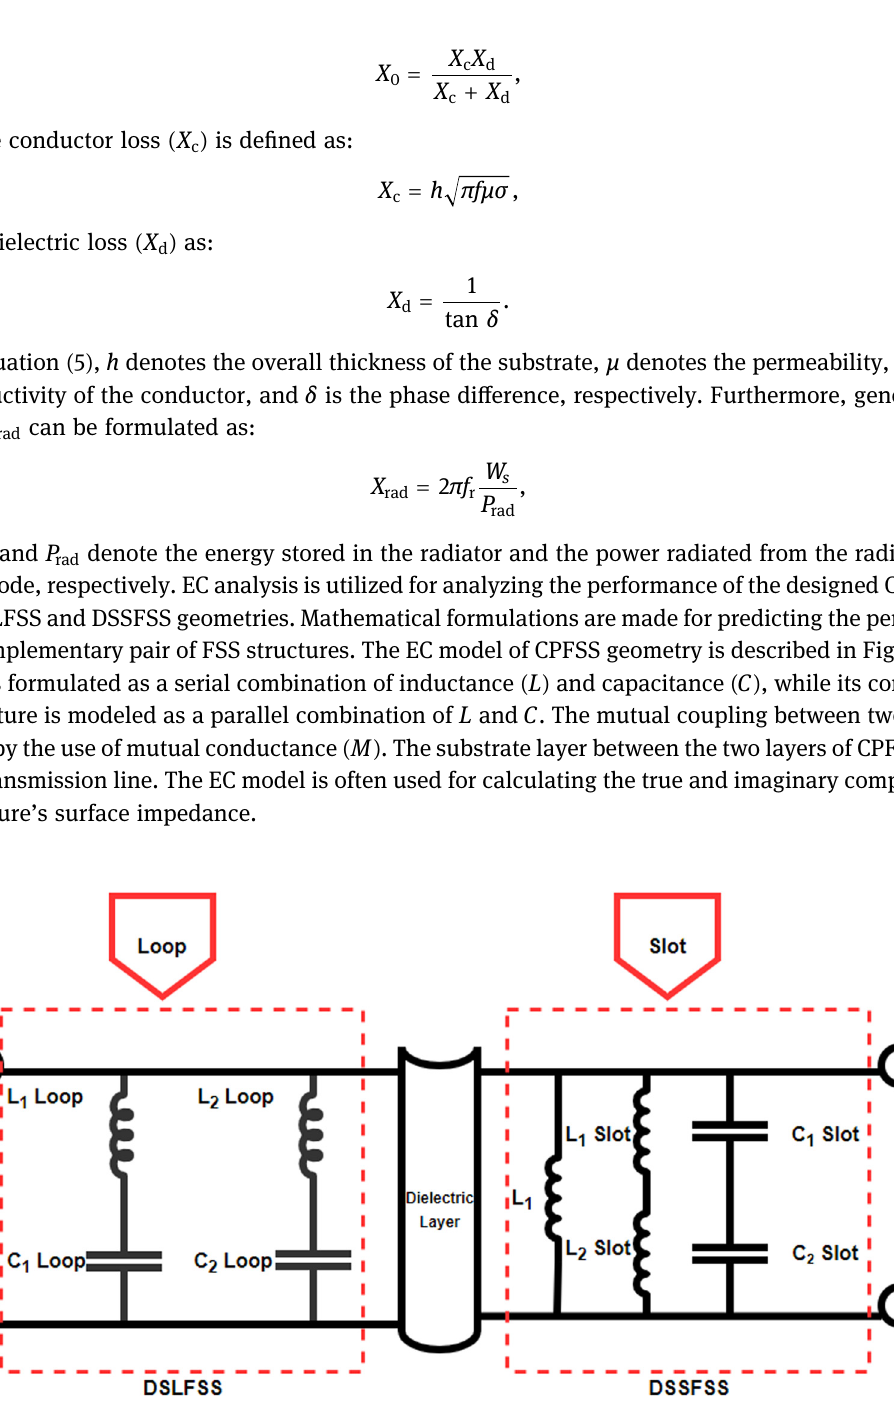
Figure 3: EC model of the CPFSS comprising DSLFSS and DSSFSS